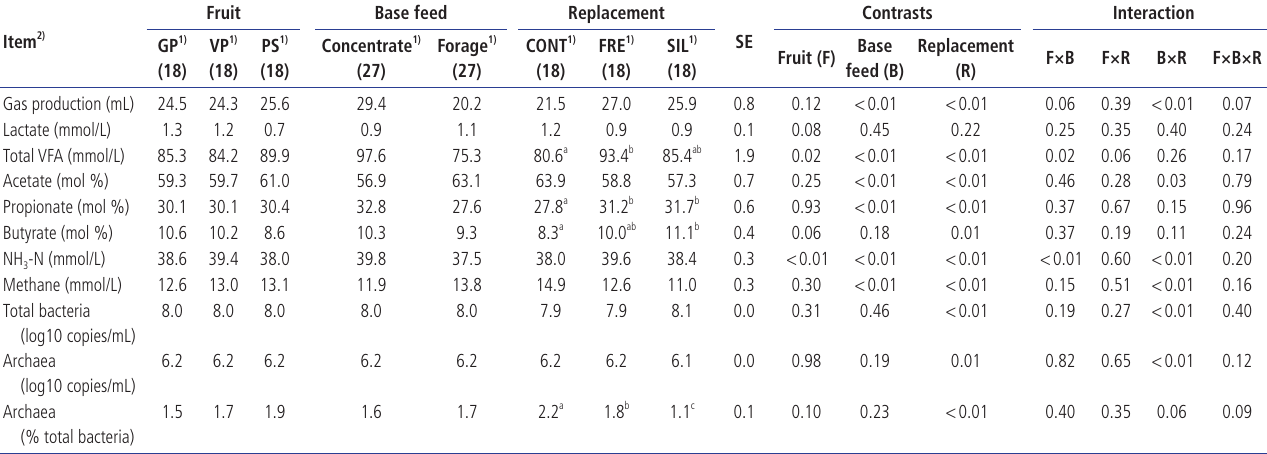
Table 3. In vitro rumen fermentation characteristics of concentrate-based or forage-based rations containing ensiled fruits byproducts Fruit Base feed Replacement Item 2)